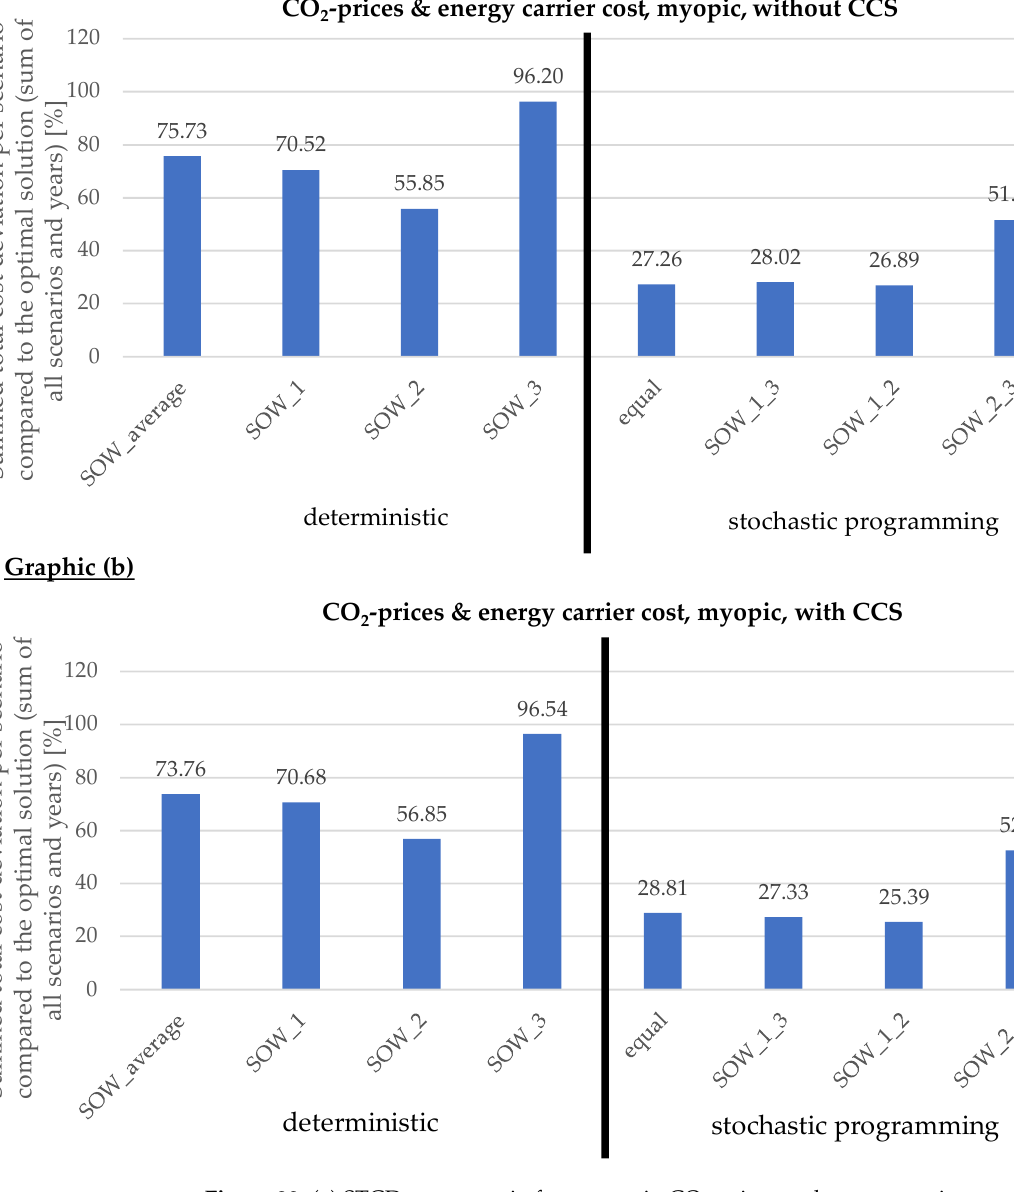
Figure 20. ( a ) STCD per scenario for uncertain CO 2 prices and energy carrier cost (myopic, without CCS); ( b ) STCD per scenario for uncertain CO 2 prices and energy carrier cost (myopic, with CCS). The high deviation of the STCDs, independent from the availability of CCS, can be explained by the diverse structure of the optimal energy system for each deterministic scenario, which leads to strong path dependencies. Figure 21 shows the installed technolo- gies for the average, low, medium, high, equal, and medium-high scenarios. Again, the SP solution is different from all deterministic solutions. this underlines that, even with the simple two-stage SP, SP already allows insight that is not retrievable by deterministic scenario